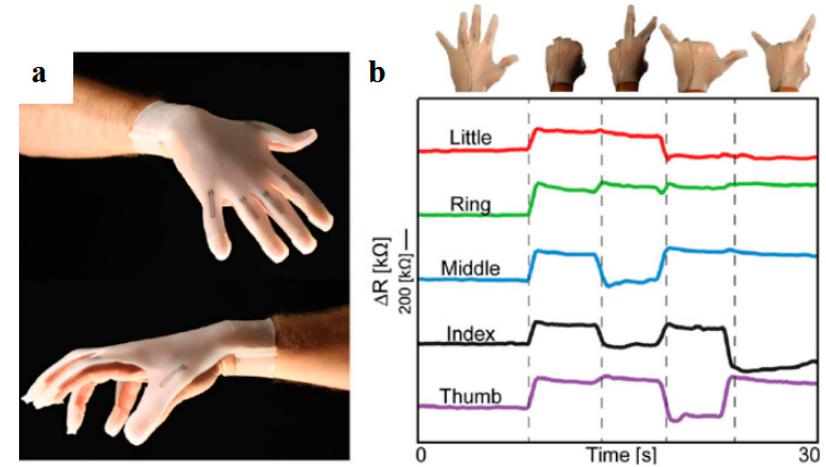
Figure 4. Microscale 3D-printed functional devices with conductive materials. ( a , b ) A glove with 3D-printed carbon-based conductive lines and its resistance response of each finger during flexing, reprinted from [36] with the permission of John Wiley and Sons, Copyright